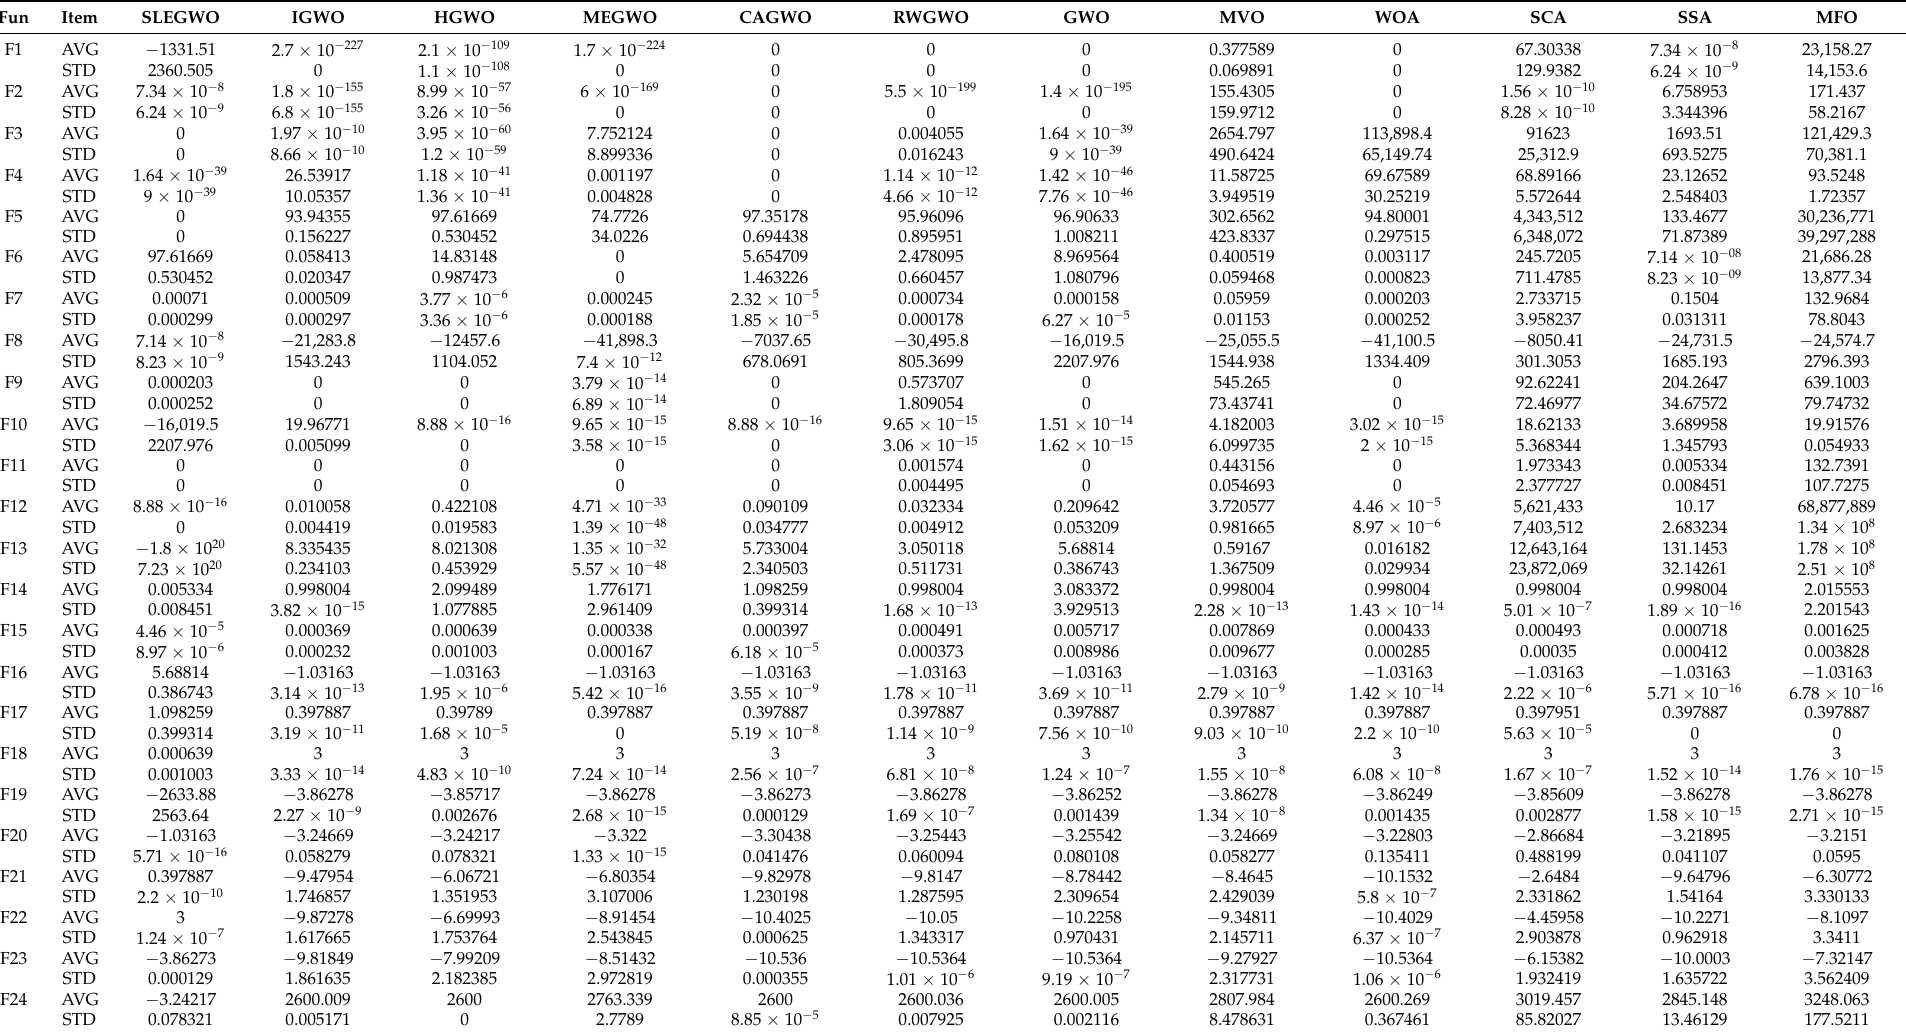
Table 1. The comparison of SLEGWO and other competitors in